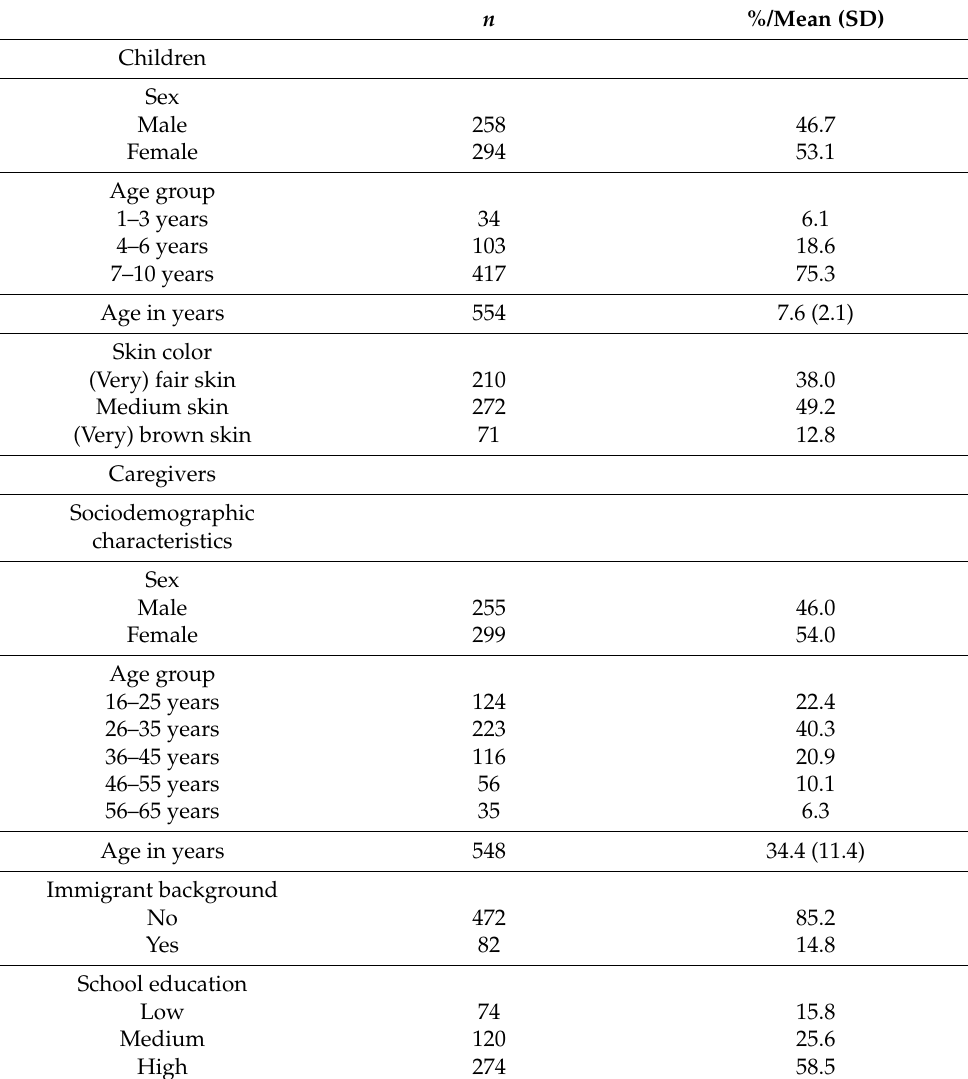
Table 1. Characteristics of study participants in the National Cancer Aid Monitoring (NCAM) in wave 2020 who reported living in the same household with at least one child aged between 1 and 10 years (caregivers) and children. n %/Mean